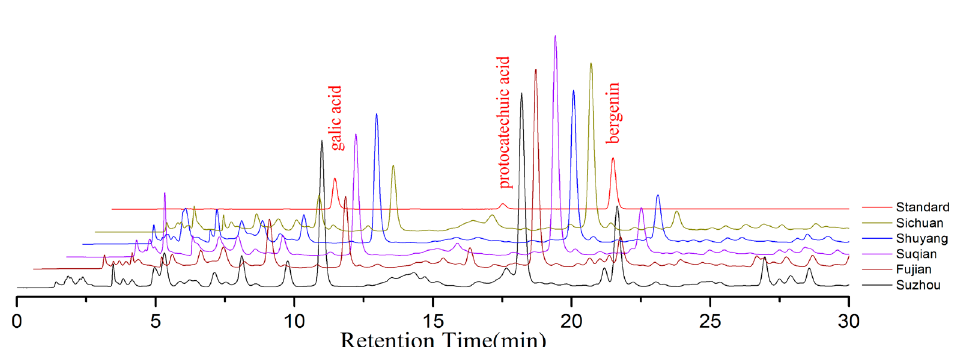
Fig. 4: The difference in content and HPLC pattern of GA, PA and bergenin in S. stolonifera cultivated in five different locations in